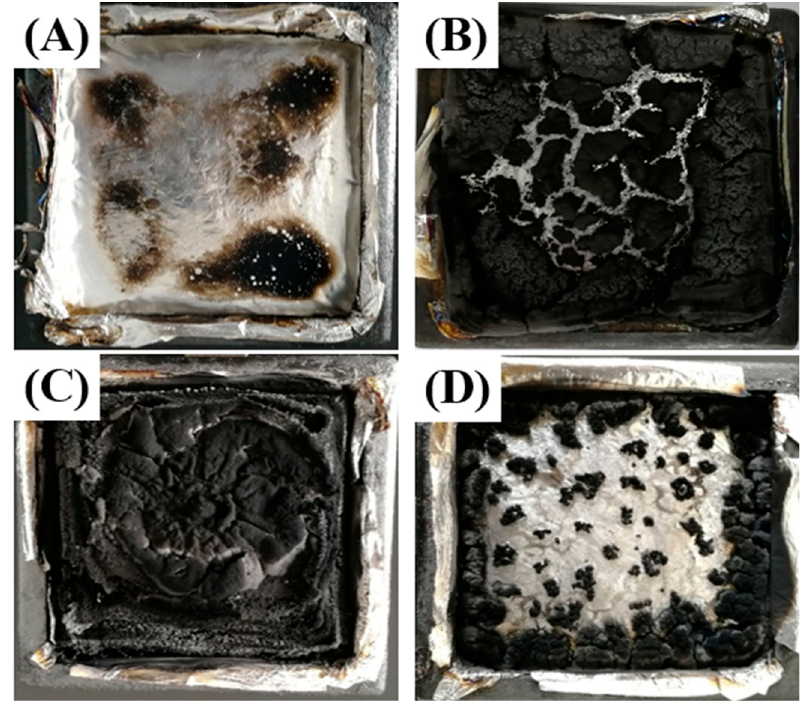
Figure 9. Photographs of residue chars of ( A ) EPDM/PP; ( B ) EPDM/PP/25% reactive IFR; ( C ) EPDM/PP/35% reactive IFR; ( D ) EPDM/PP/25% compound IFR. Table 5. Cone calorimeter data of reactive flame retardant EPDM/PP/IFR composites with different IFR contents.